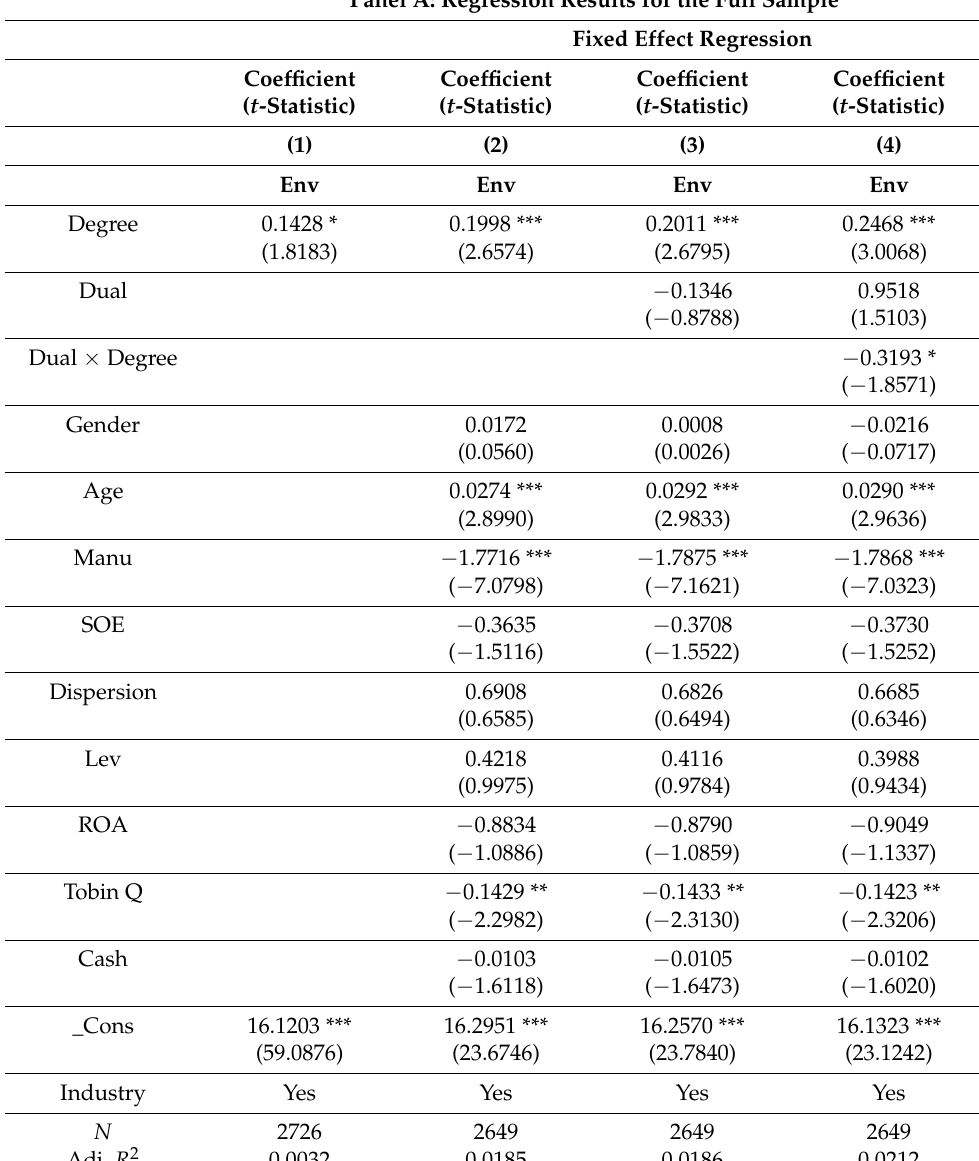
Table 4. Baseline regression results: CEO education, duality, and corporate environmental protection